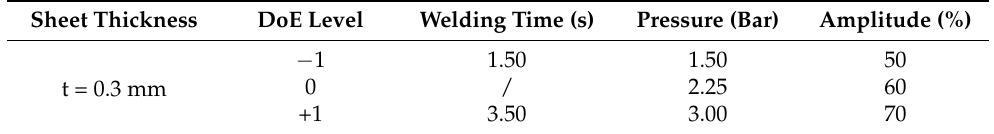
Figure 6. Heat development around the weld nugget (top view and bottom view, respectively). Peel testing was performed for each parameters combination to have an initial indi- cation of the weld quality. It is noticed that the number of welds with a peel test score of 3 or 1 was large for the 0.3 mm thick sheets. This indicates that it is difficult to achieve a satisfactory weld for a small sheet thickness of 0.3 mm, even though the parameters are chosen within the parameter window. Not all combinations of parameter values within the parameter window resulted in a sound joint between the workpieces. The parameter settings corresponding to the different points of the DoE matrix are shown in Table 2. No intermediate value of welding time is chosen for the test series because observations during the exploratory welds indicated that the welding time had lower influence on the weld quality within the limits considered. Table 2. Parameter values of the DoE matrix.